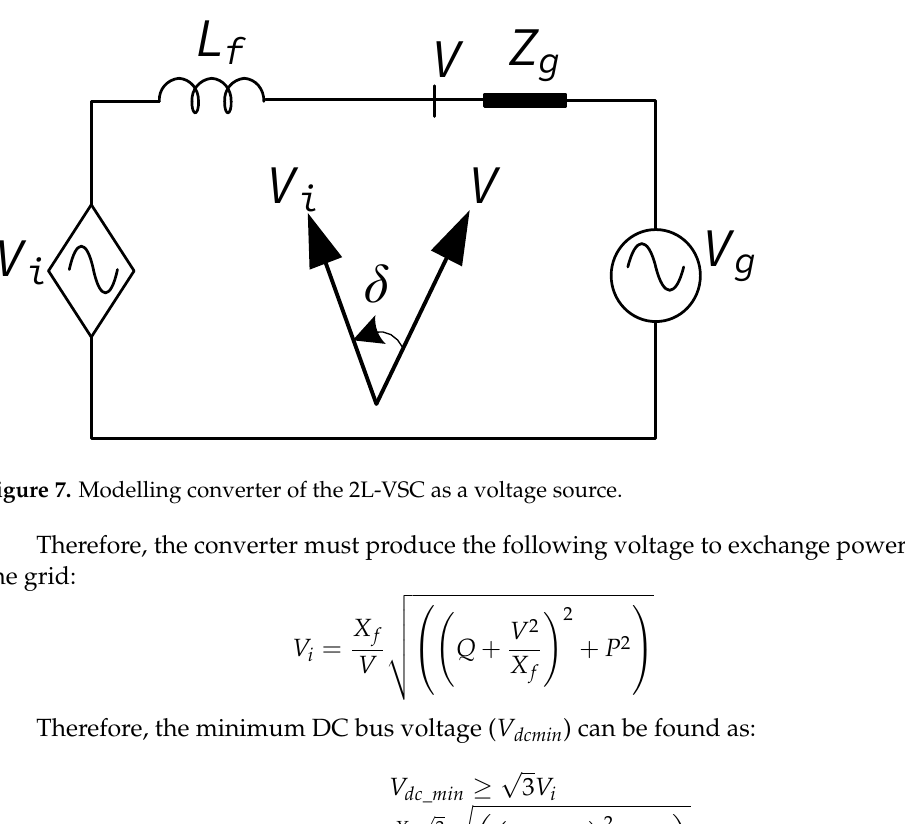
Figure 8. Minimum DC link voltage ( V dcmin ) based on active and reactive powers.